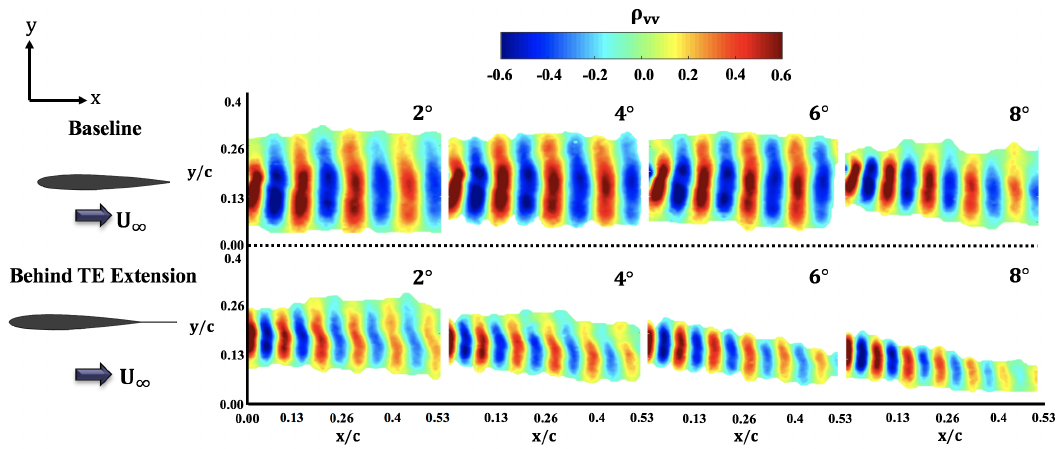
Figure 17. Contours of two-point correlation of the transverse velocity component for the baseline wing and for the wing with TE extensions. Similar to ρ u , weaker correlations are observed in the i u j wake behind the TE extension lower velocity fluctuations. Also, the decrease in wavelength of the correlation indicates a decrease in turbulent length